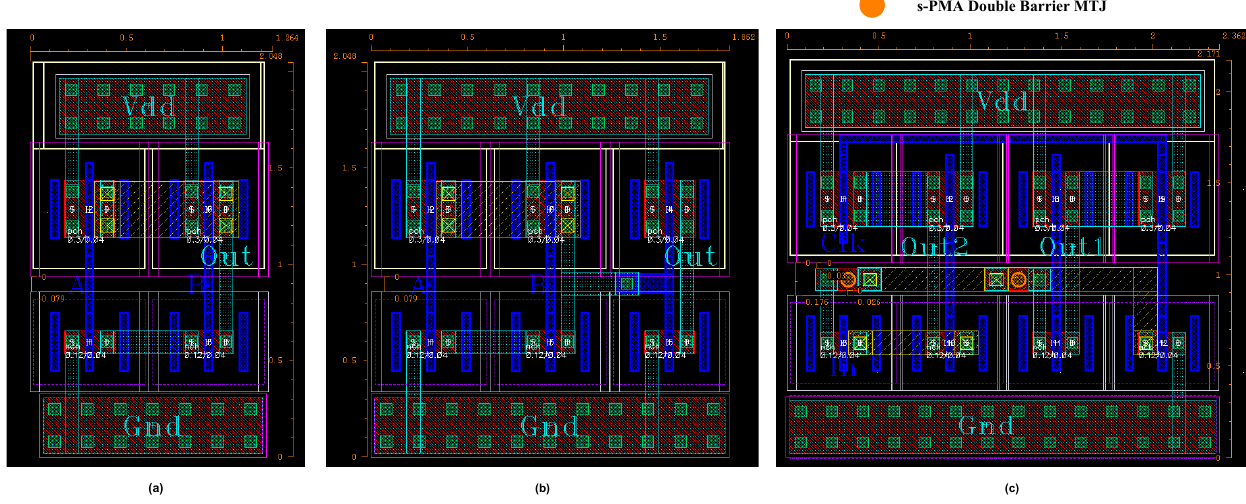
Figure 8. Layout of ( a ) CMOS NAND logic gate; ( b ) CMOS AND logic gate; ( c ) the LL block used in this